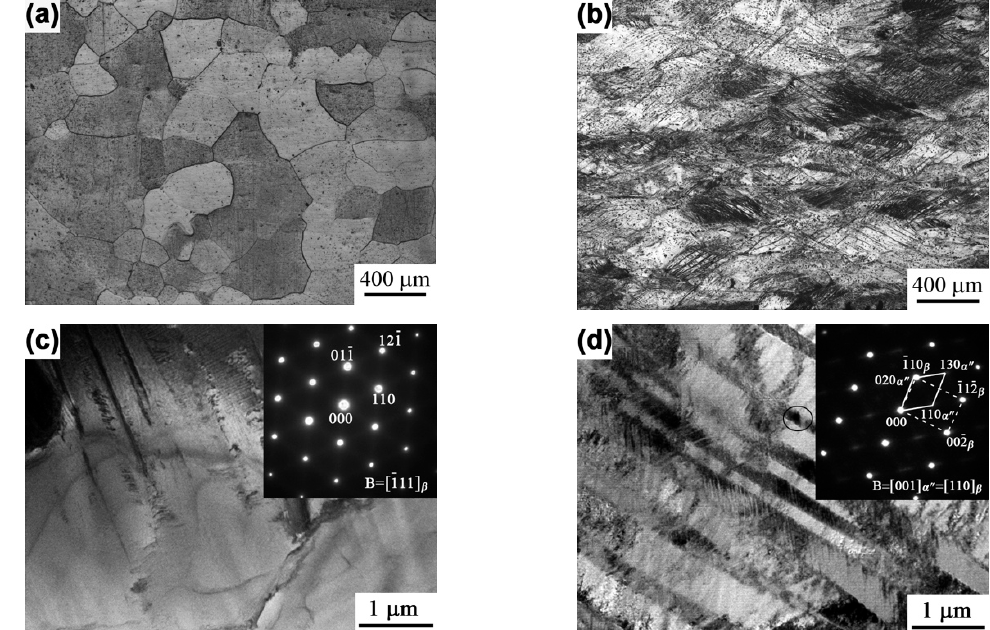
Materials 2019 , 12 , x FOR PEER REVIEW 4 of 12